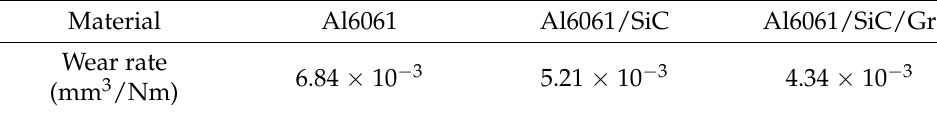
Table 2. Wear rate